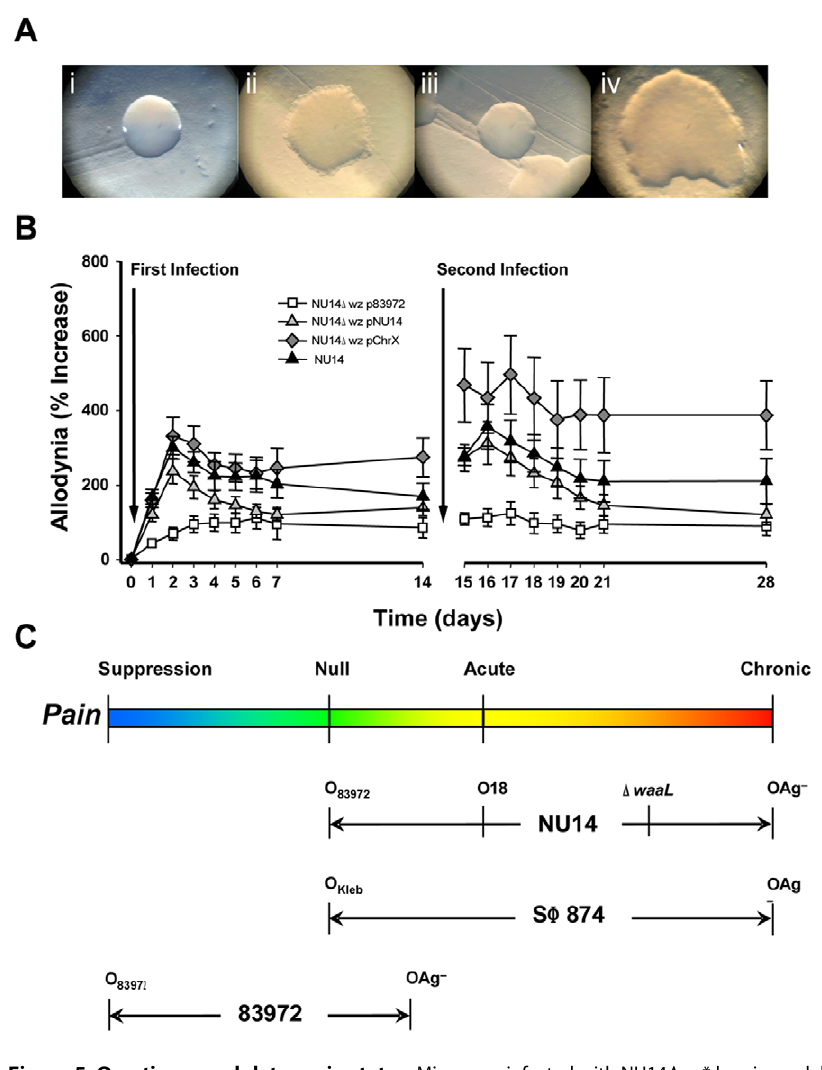
Figure 5. O-antigen modulates pain states. Mice were infected with NU14 D wz * bearing a deletion of the O-antigen gene clusters and harboring like or heterologous complementation constructs. ( A ) NU14 smooth colony morphology (i) is rough in the NU14 D wz * mutant with a human X chromosome plasmid (ii) or a 83972 wz * plasmid (iv) but is rescued by an NU14 wz * plasmid (iii). ( B ) Tactile allodynia of mice in response to sequential infection with NU14 or NU14 D wz* containing plasmids with the wz* cluster of 83972, NU14, or a fragment of the human X chromosome (n=10). ( C ) Summary of O-antigen modulation of pain responses.